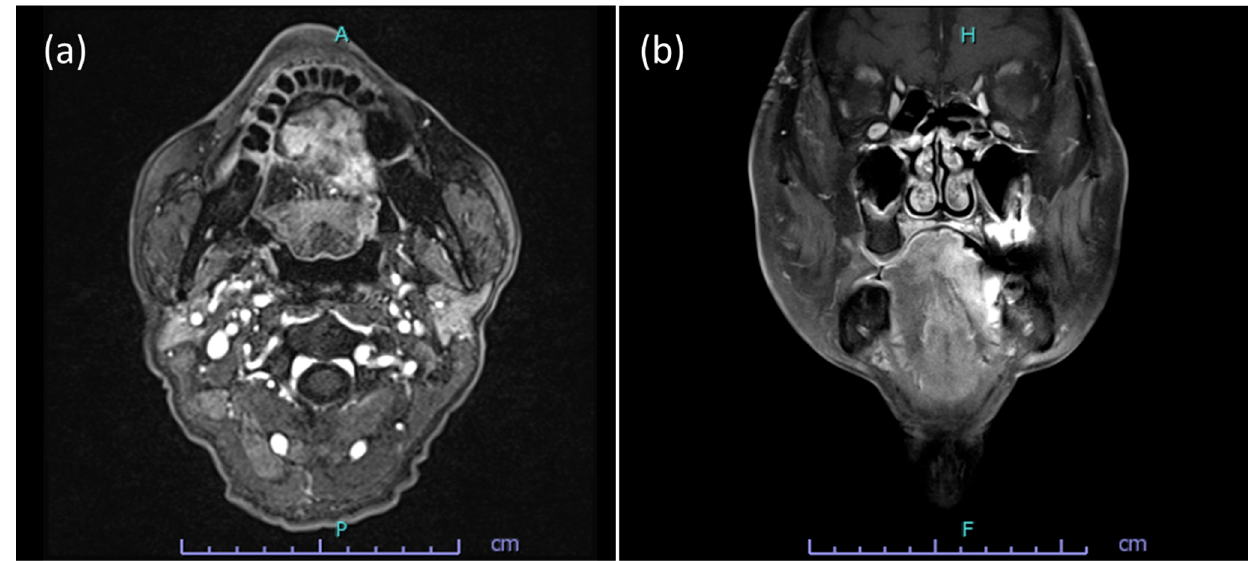
Figure 2. Radiographic findings of the tumor. ( a , b ) The tumor localized in the body of the tongue and occupied more than half of the tongue. The cervical lymph node is not enlarged.